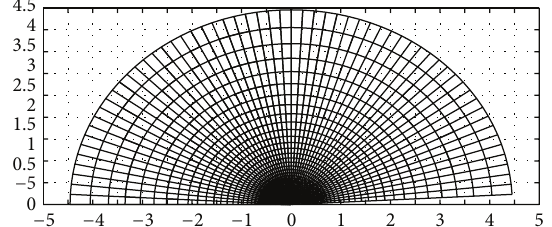
Figure 8: Computational grid in the polar coordinate system tied to the surface.